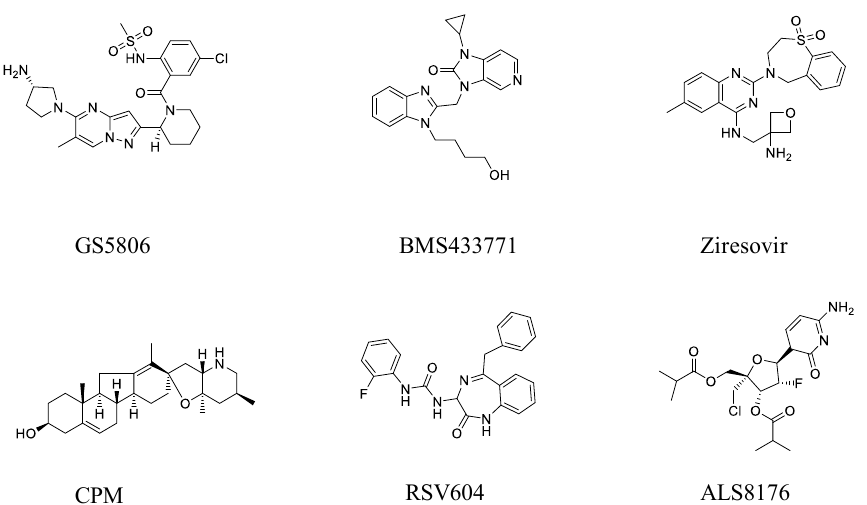
Figure 1. The chemical structural formulas of GS5806, BMS433771, Ziresovir, CPM, RSV604, and ALS8176.